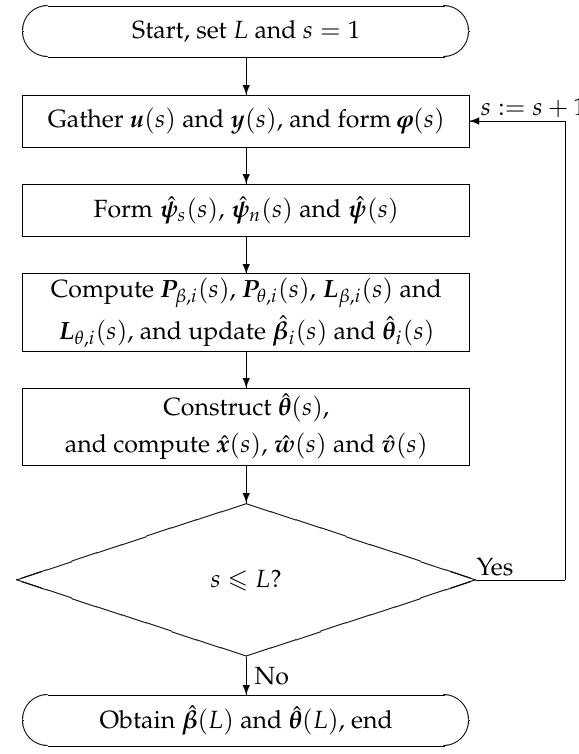
Figure 2. The flowchart of computing the PC-RGELS parameter estimates ˆ β ( L ) and ˆ θ ( L ) . 5.